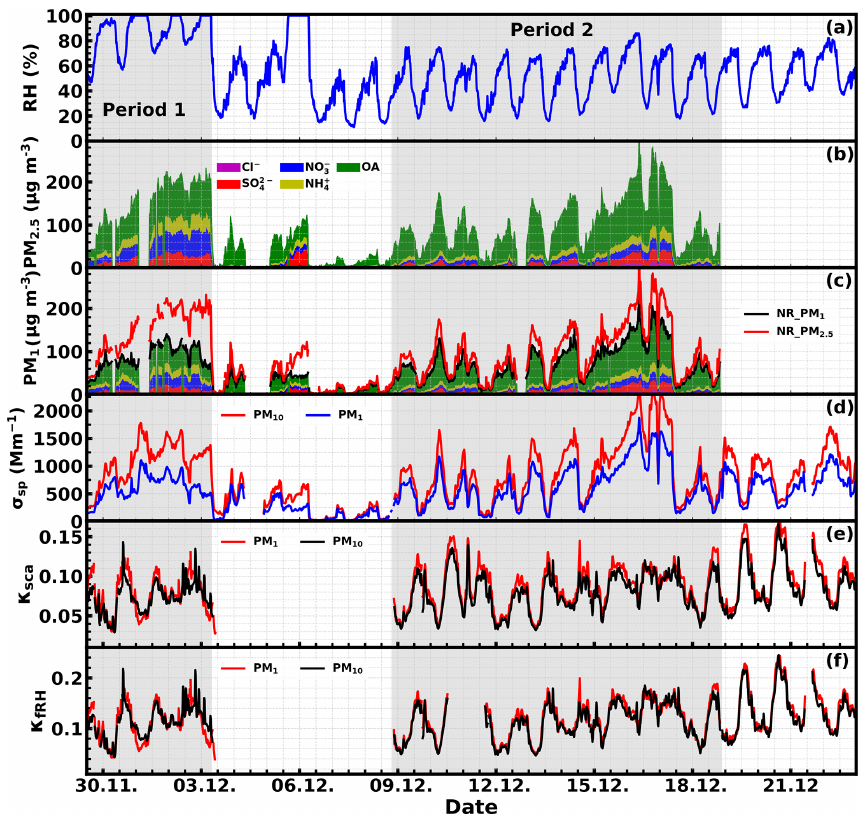
Figure 5. Time series of ambient RH (a) , chemical compositions of PM 2 . 5 (b) and PM 1 (c) , σ sp at 525nm of PM 10 and PM 1 (d) , and calculated κ sca (e) and κ f( RH ) (f) values of PM 10 and PM 1 .